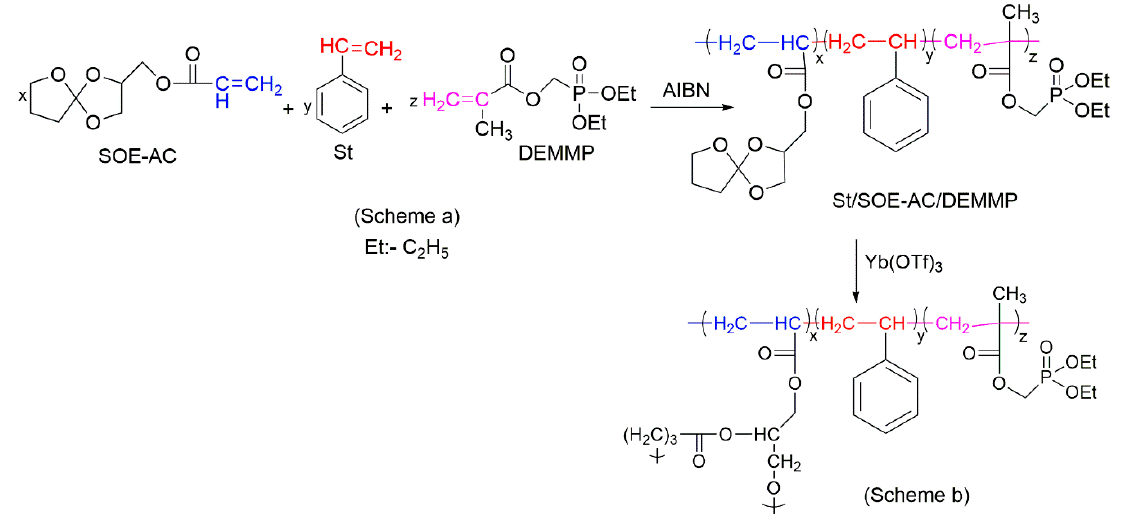
Figure18. Schemesof ter- polymerisationofStandaringopeningof1,4,6-trioxaspiro[4,4]-2-nonylmethyl Figure 18. Schemes of ter- polymerisation of St and a ring opening of 1,4,6-trioxaspiro[4,4]-2- acrylate (SOE-AC) moieties nonylmethyl acrylate (SOE-AC) moieties [110].